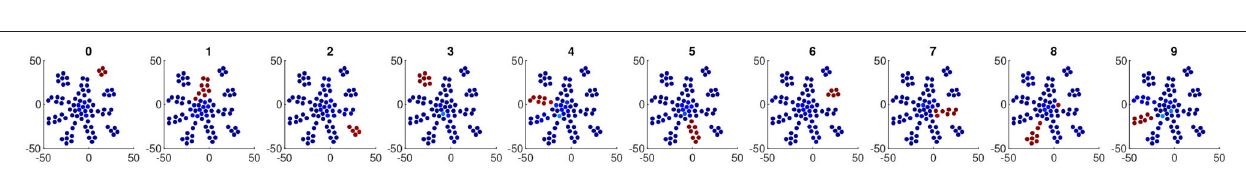
FIGURE 2 | Neuronal assembly patterns found in neurons’ weight space of the dense layer of different models on both MNIST (top) and CIFAR-10 (bottom) datasets, along with clustering validation via Silhouette score on 10 clusters K-means clustering. The dimensionality of neurons’ weight space was reduced to 2D with T-SNE for visualization.